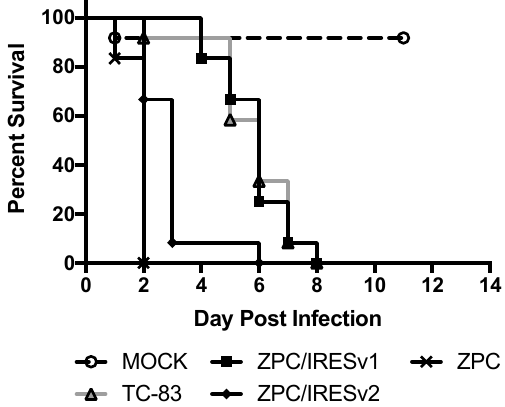
Figure 4. Survival in vaccinated mice following lethal intranasal 3908